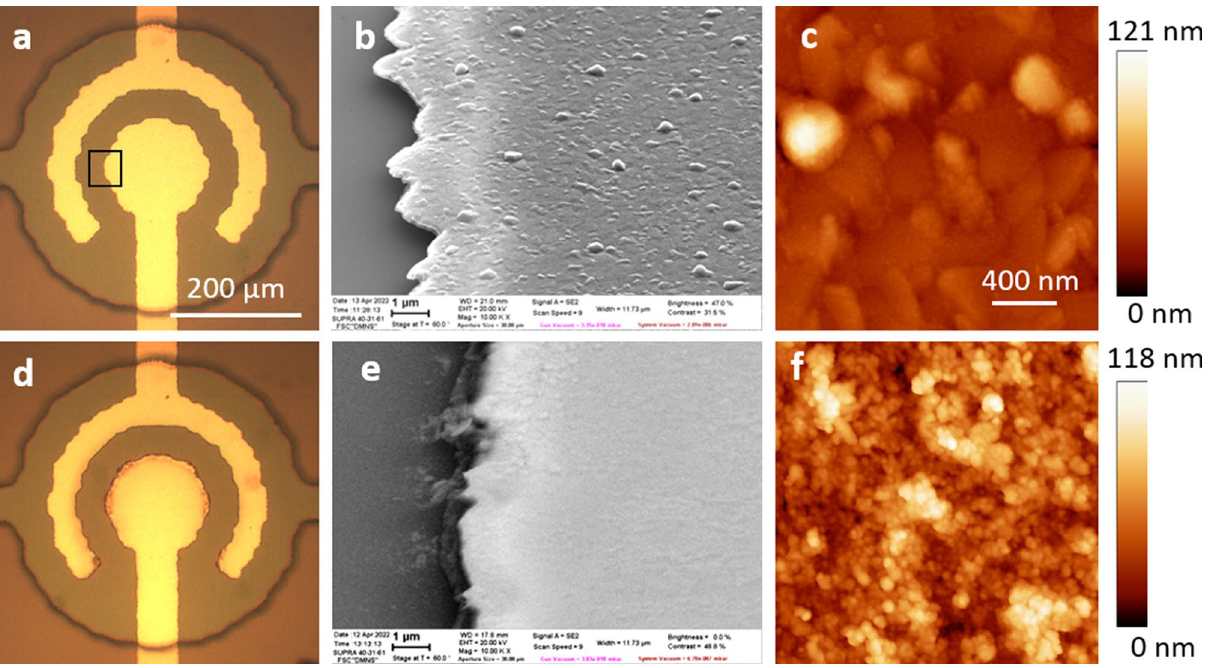
Figure 5. Surface of the electrodes before and after the long-time test. ( a ) Optical image of the chamber and electrodes before the test. The black rectangular indicates the area investigated with SEM and AFM. ( b ) SEM image of the edge of the central electrode. ( c ) AFM image made in the same area as the SEM image in ( b ). The color axis is shown on the right of the image. ( d – f ) Show the same as ( a – c ) but after 5 h test with the parameters f c = 10 Hz, U = 10.5 V, and f = 500